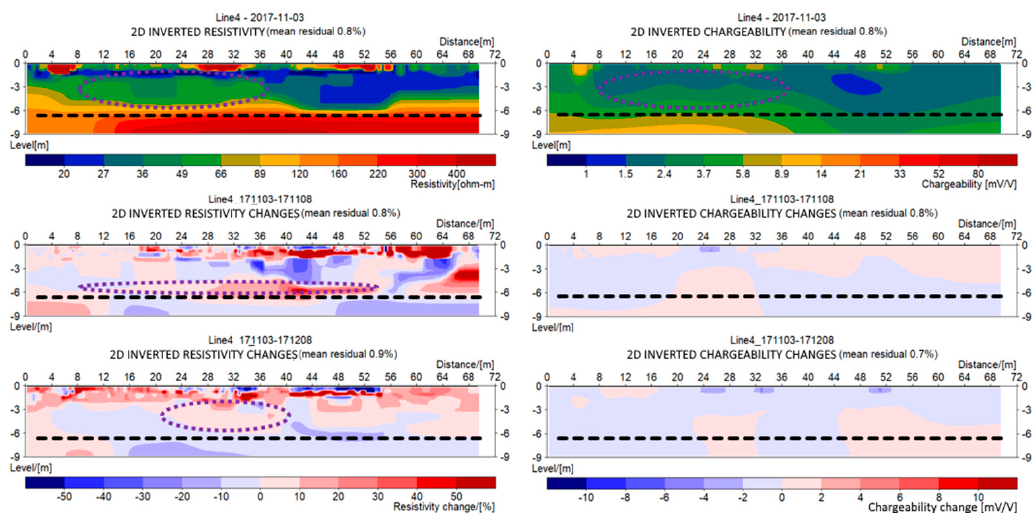
Figure 10. DCIP results from Line 4 (down gradient the injection area) baseline measurements 3rd of November 2017 (top) and time lapse changes between ( left ) the baseline and during the first injection 8th of November 2017 (middle) ( right ) the baseline and after second injection 8th of December 2017 (bottom). Resistivity results are shown on the left and chargeability on the right. The purple dashed line indicates the contamination plume based on the joint interpratation of the conceptual model and the geophysical